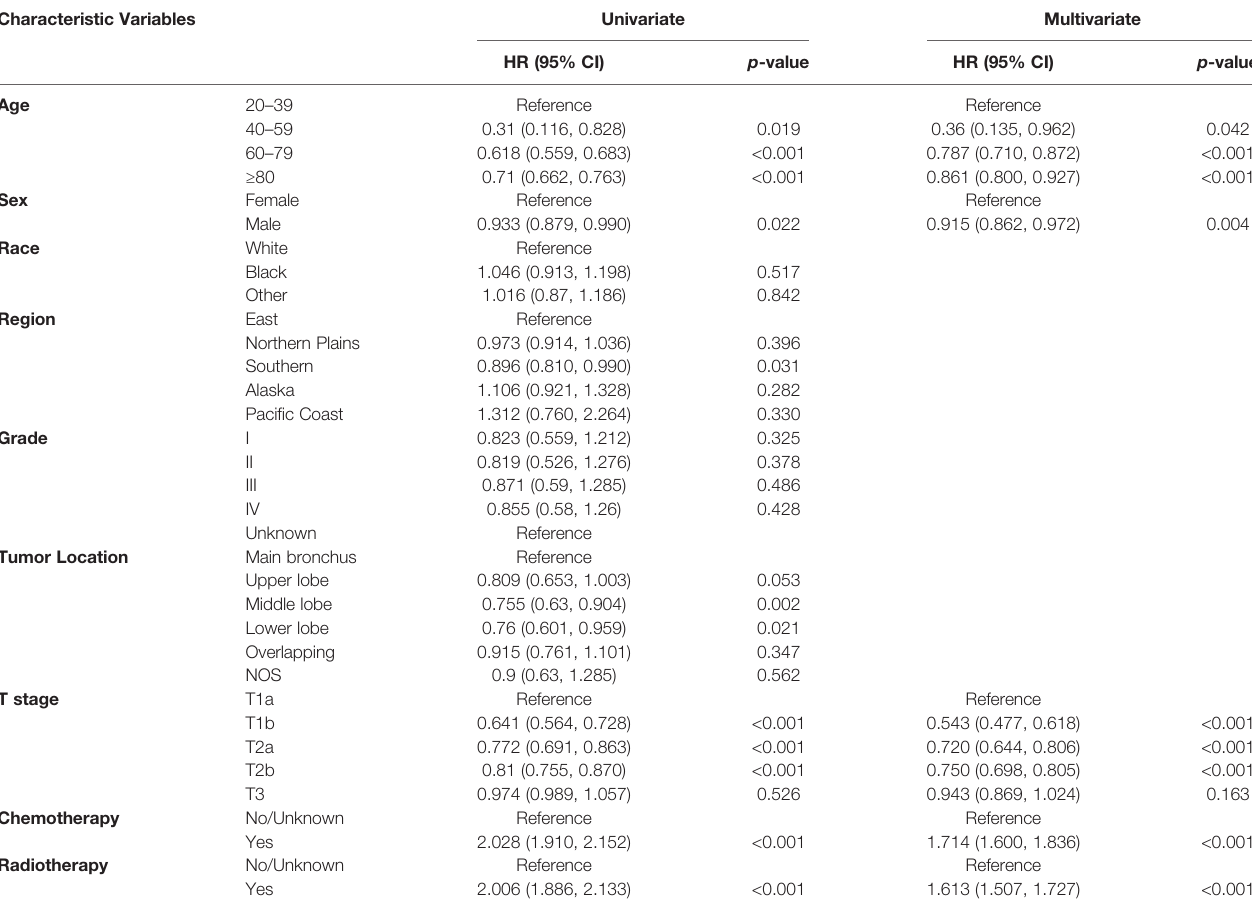
TABLE 2 | Univariate and multivariate analyses for OS in patients with unresectable IIIA-N2 LUSC. Characteristic